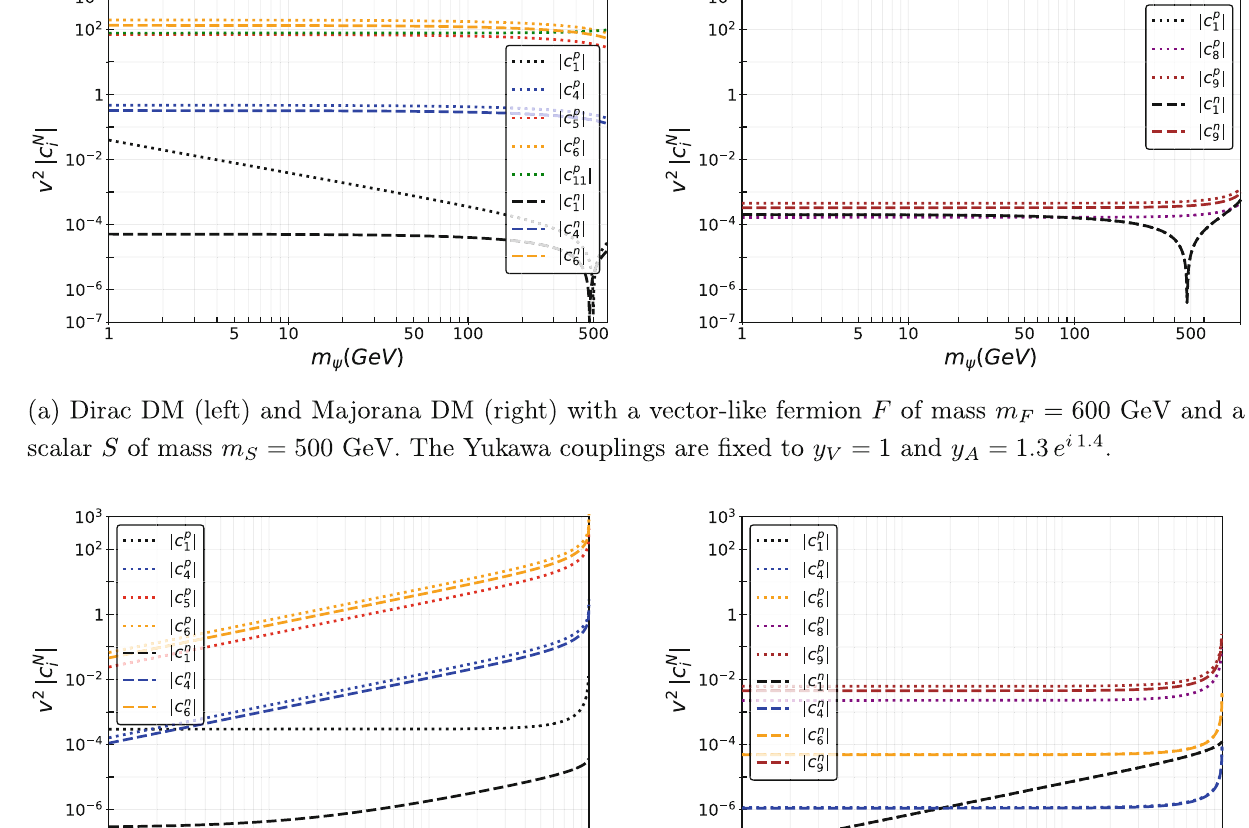
coefficients are displayed in dimensionless units by rescaling with the square of the electroweak VEV v = 246 . 2